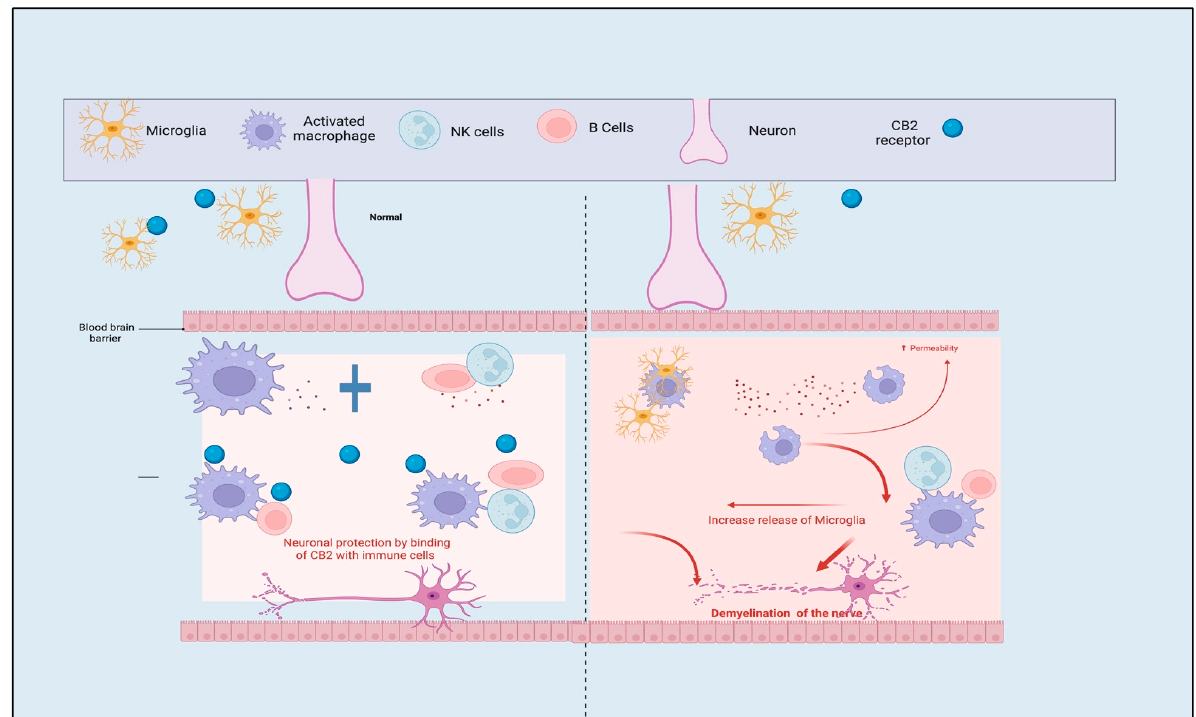
Figure 2. The physiological function of the CB2 receptor during leukocyte transmigration and inflammation, the transport of immune cells across the BBB is restricted by CB2 receptors. CB2: cannabinoid-2 receptor, NK: natural killer cells, B cells: B lymphocytes cells.